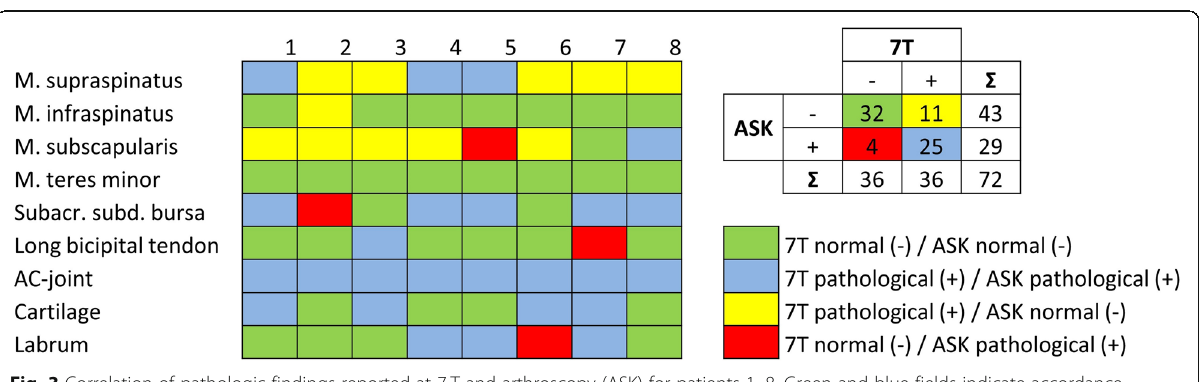
Fig. 3 Correlation of pathologic findings reported at 7 T and arthroscopy (ASK) for patients 1 – 8. Green and blue fields indicate accordance between the modalities, whereas yellow fields represent overrating and red fields represent underrating with 7-T